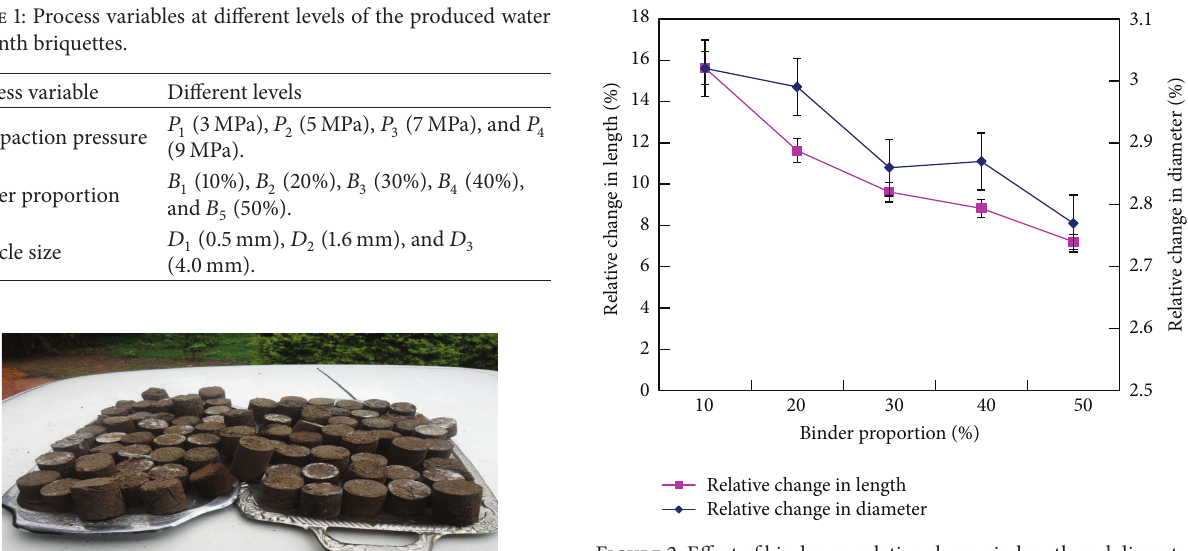
Figure 2: Effect of binder on relative change in length and diameter of